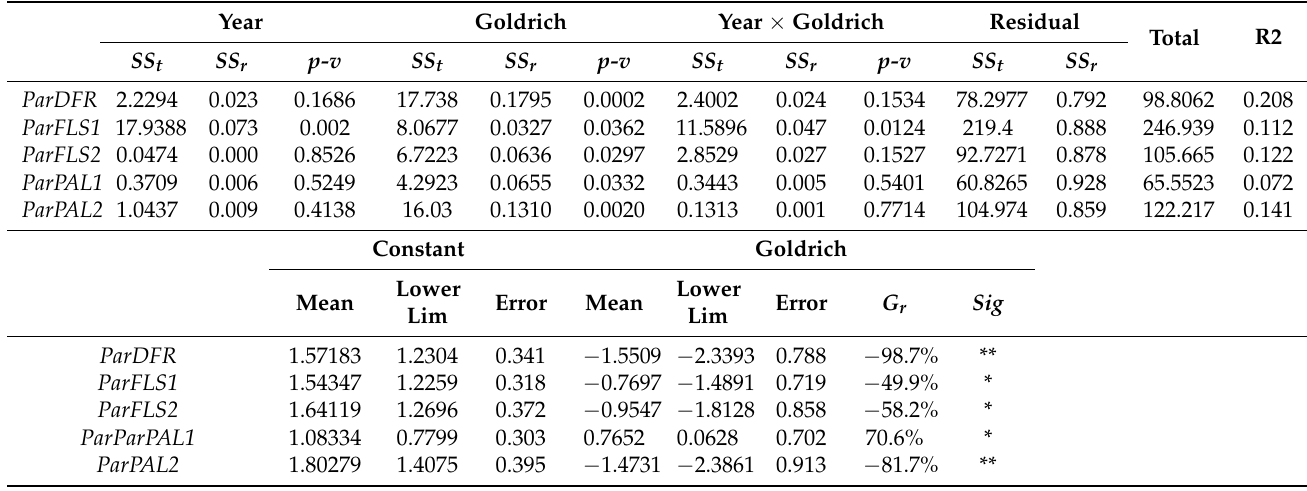
Table 3. ‘Goldrich’ contribution to genetic expression: Sum of squares and model parameters coefficients. SS r : SS relative; SS t : SS total; p-v : p -value; G r : Goldrich relative; Sig :